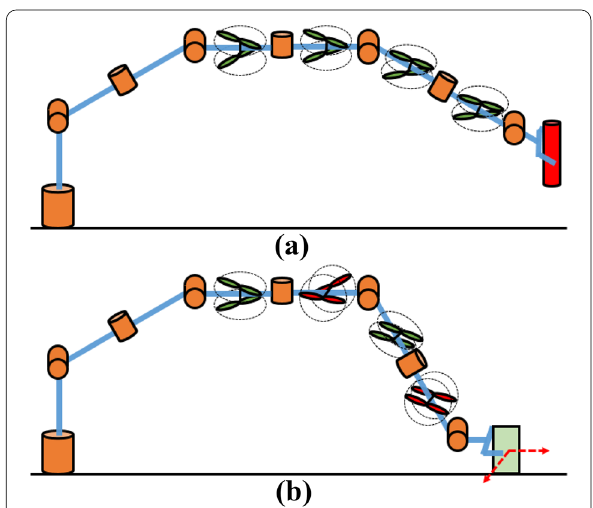
Fig. 2 a Flying watches help a long arm pick up an object. b Flying watches help a long arm push debris on the ground in different directions. Rotation axes of red flying watches are on horizontal planes. Rotation axes of green flying watches are on vertical planes containing the corresponding attached